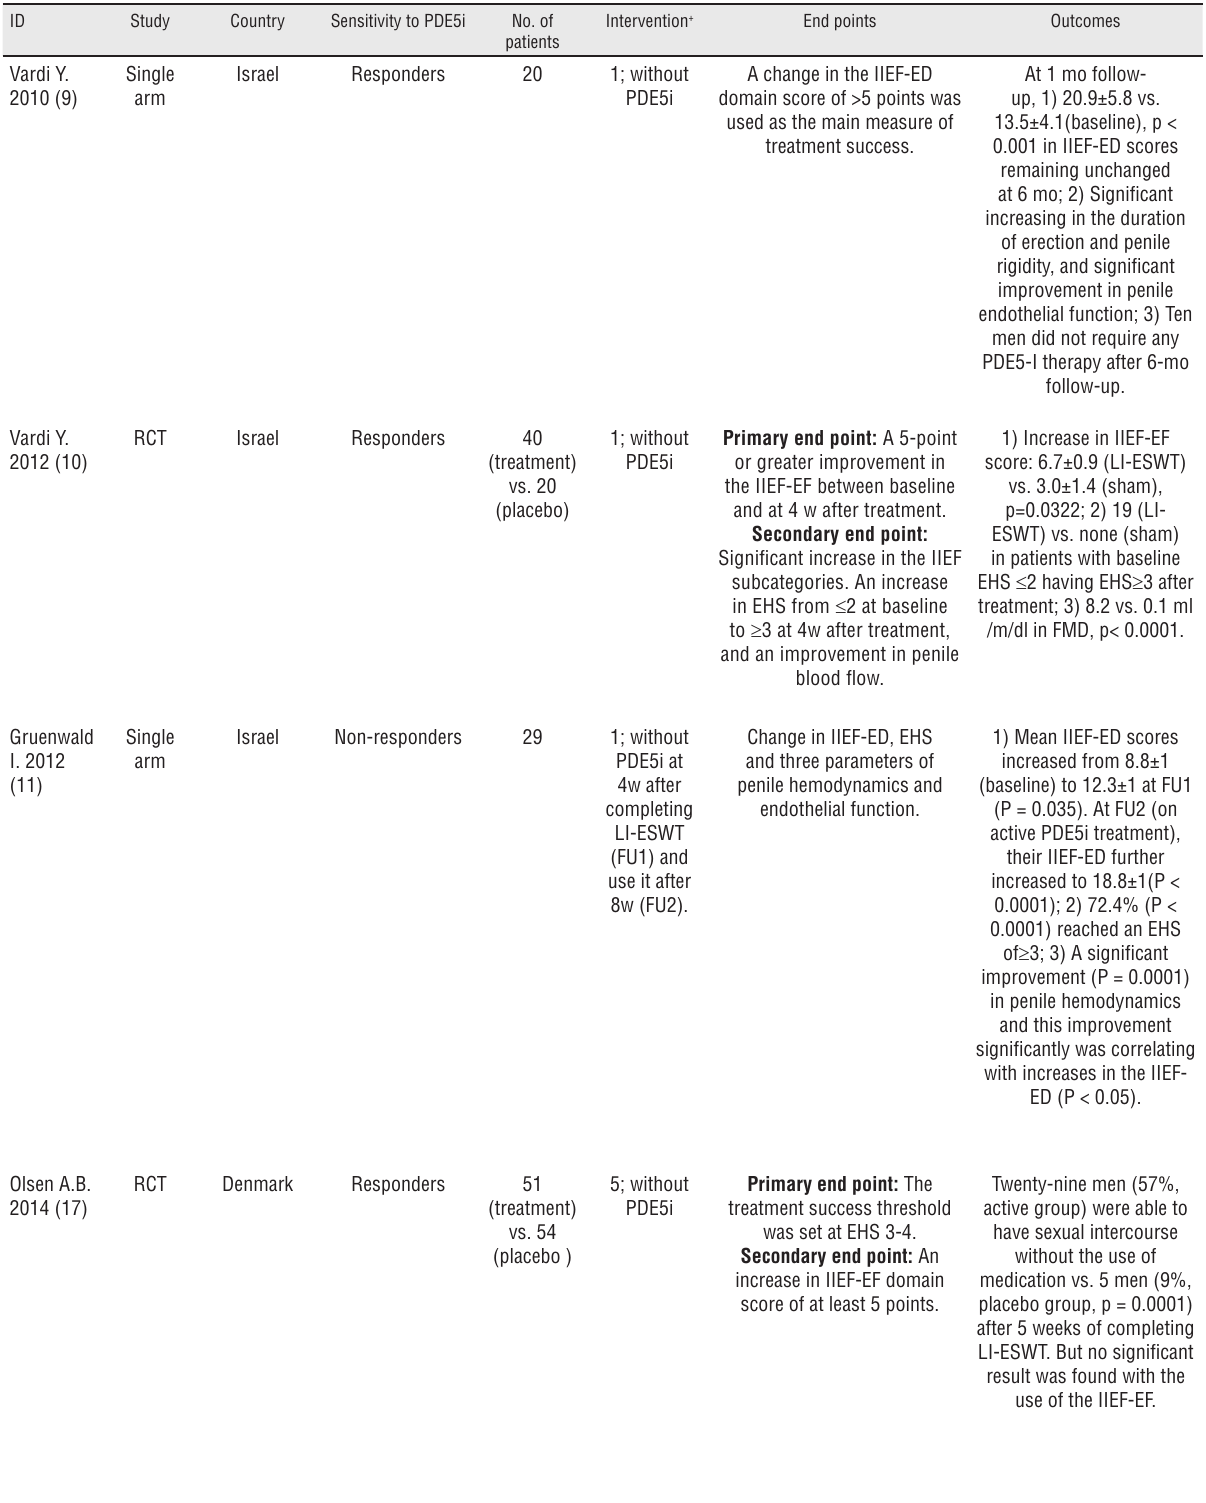
Table 1- Characteristics of the included studies in the systematic